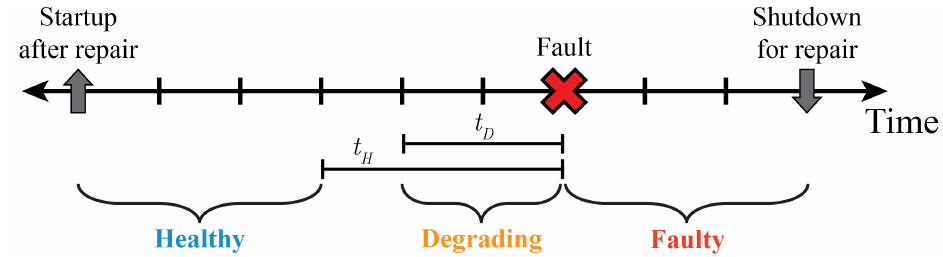
Figure 4. Historical data labeling